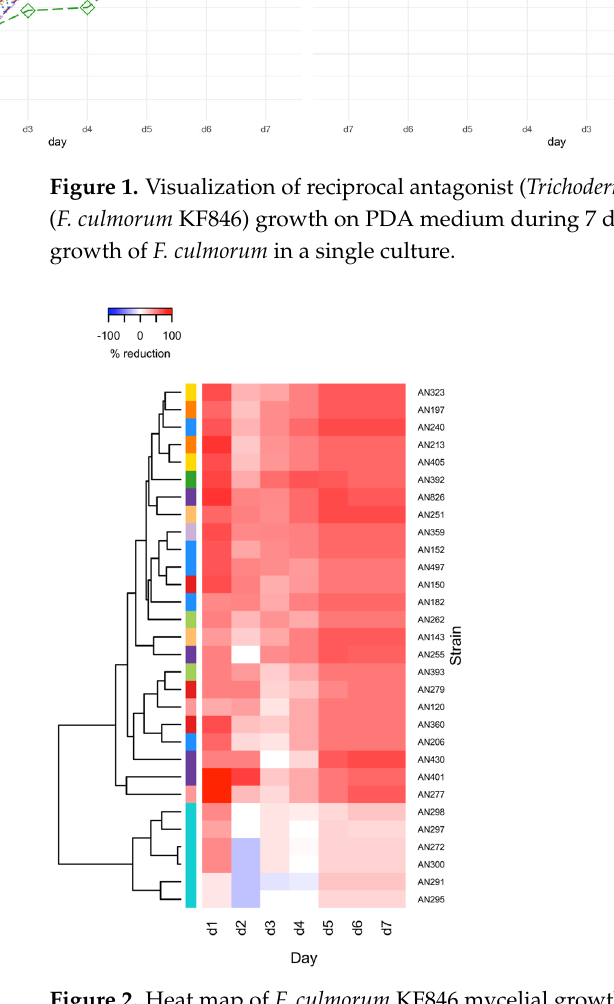
Figure 3. The qualitative evaluation of the F. culmorum KF846 —Clonostachys and F. culmorum KF846 —Trichoderma interaction after 14 days of co ‐ incubation on PDA medium by using modified Ma ń ka [36]. The symbol represents a median of three replications.